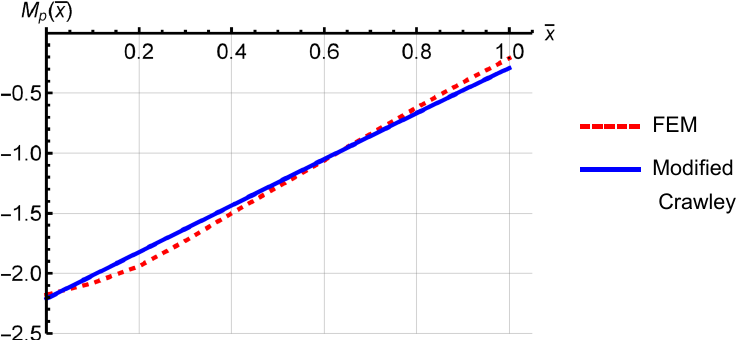
Figure 3. Comparison of the analytical (Equation (6)) and FEM bending moment exerted by the PPs considering c = 5 and ¯ x = x L